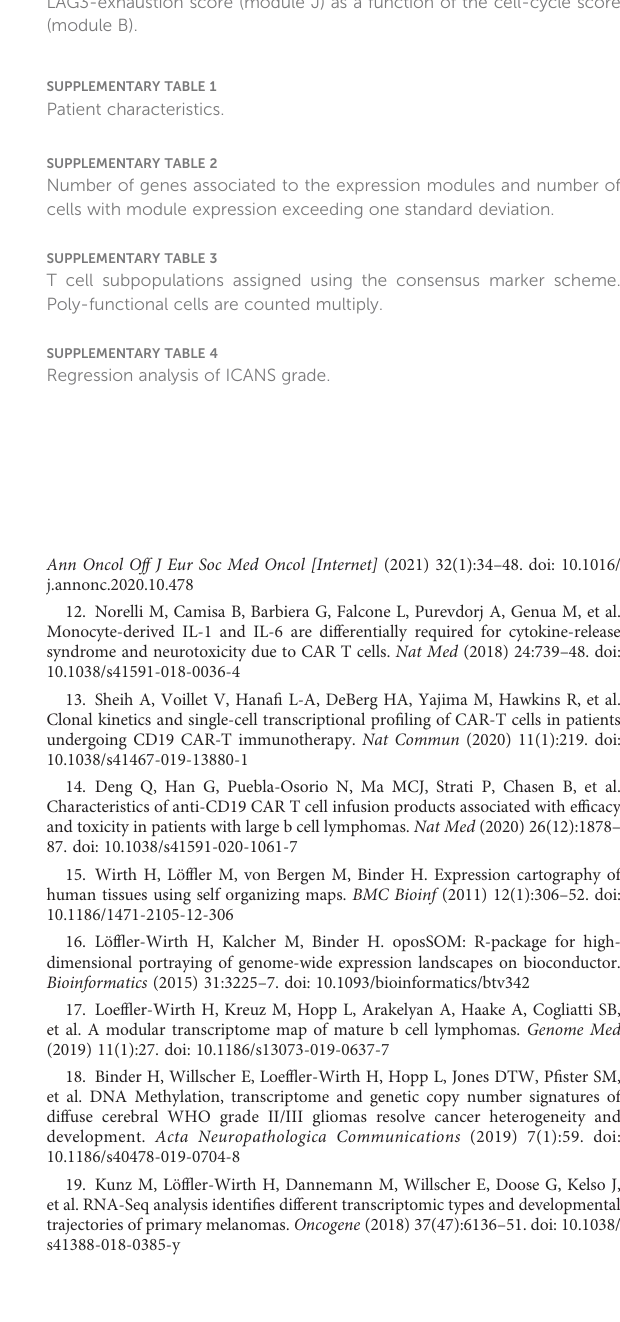
SUPPLEMENTARY FIGURE 11 LAG3-exhaustion score (module J) as a function of the cell-cycle score (module B).